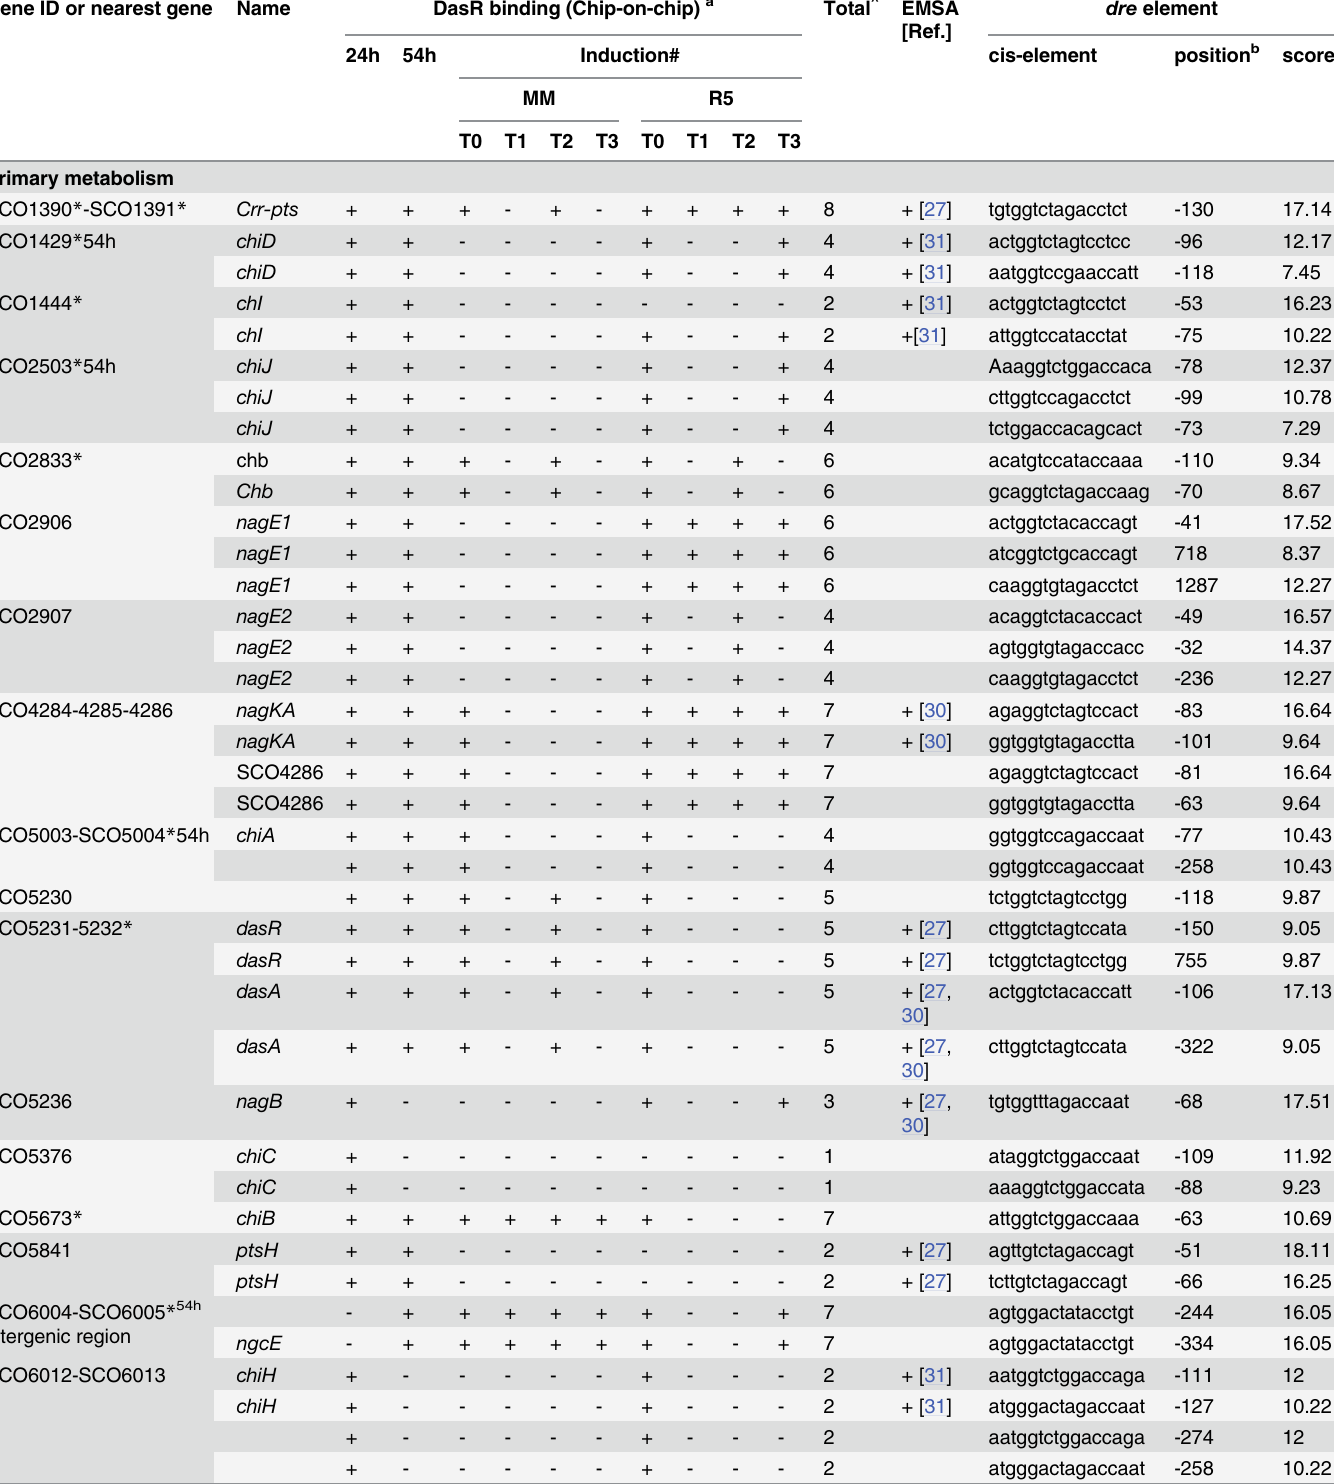
Table 1. DasR binding sites identified by ChIP-on-chip experiments and